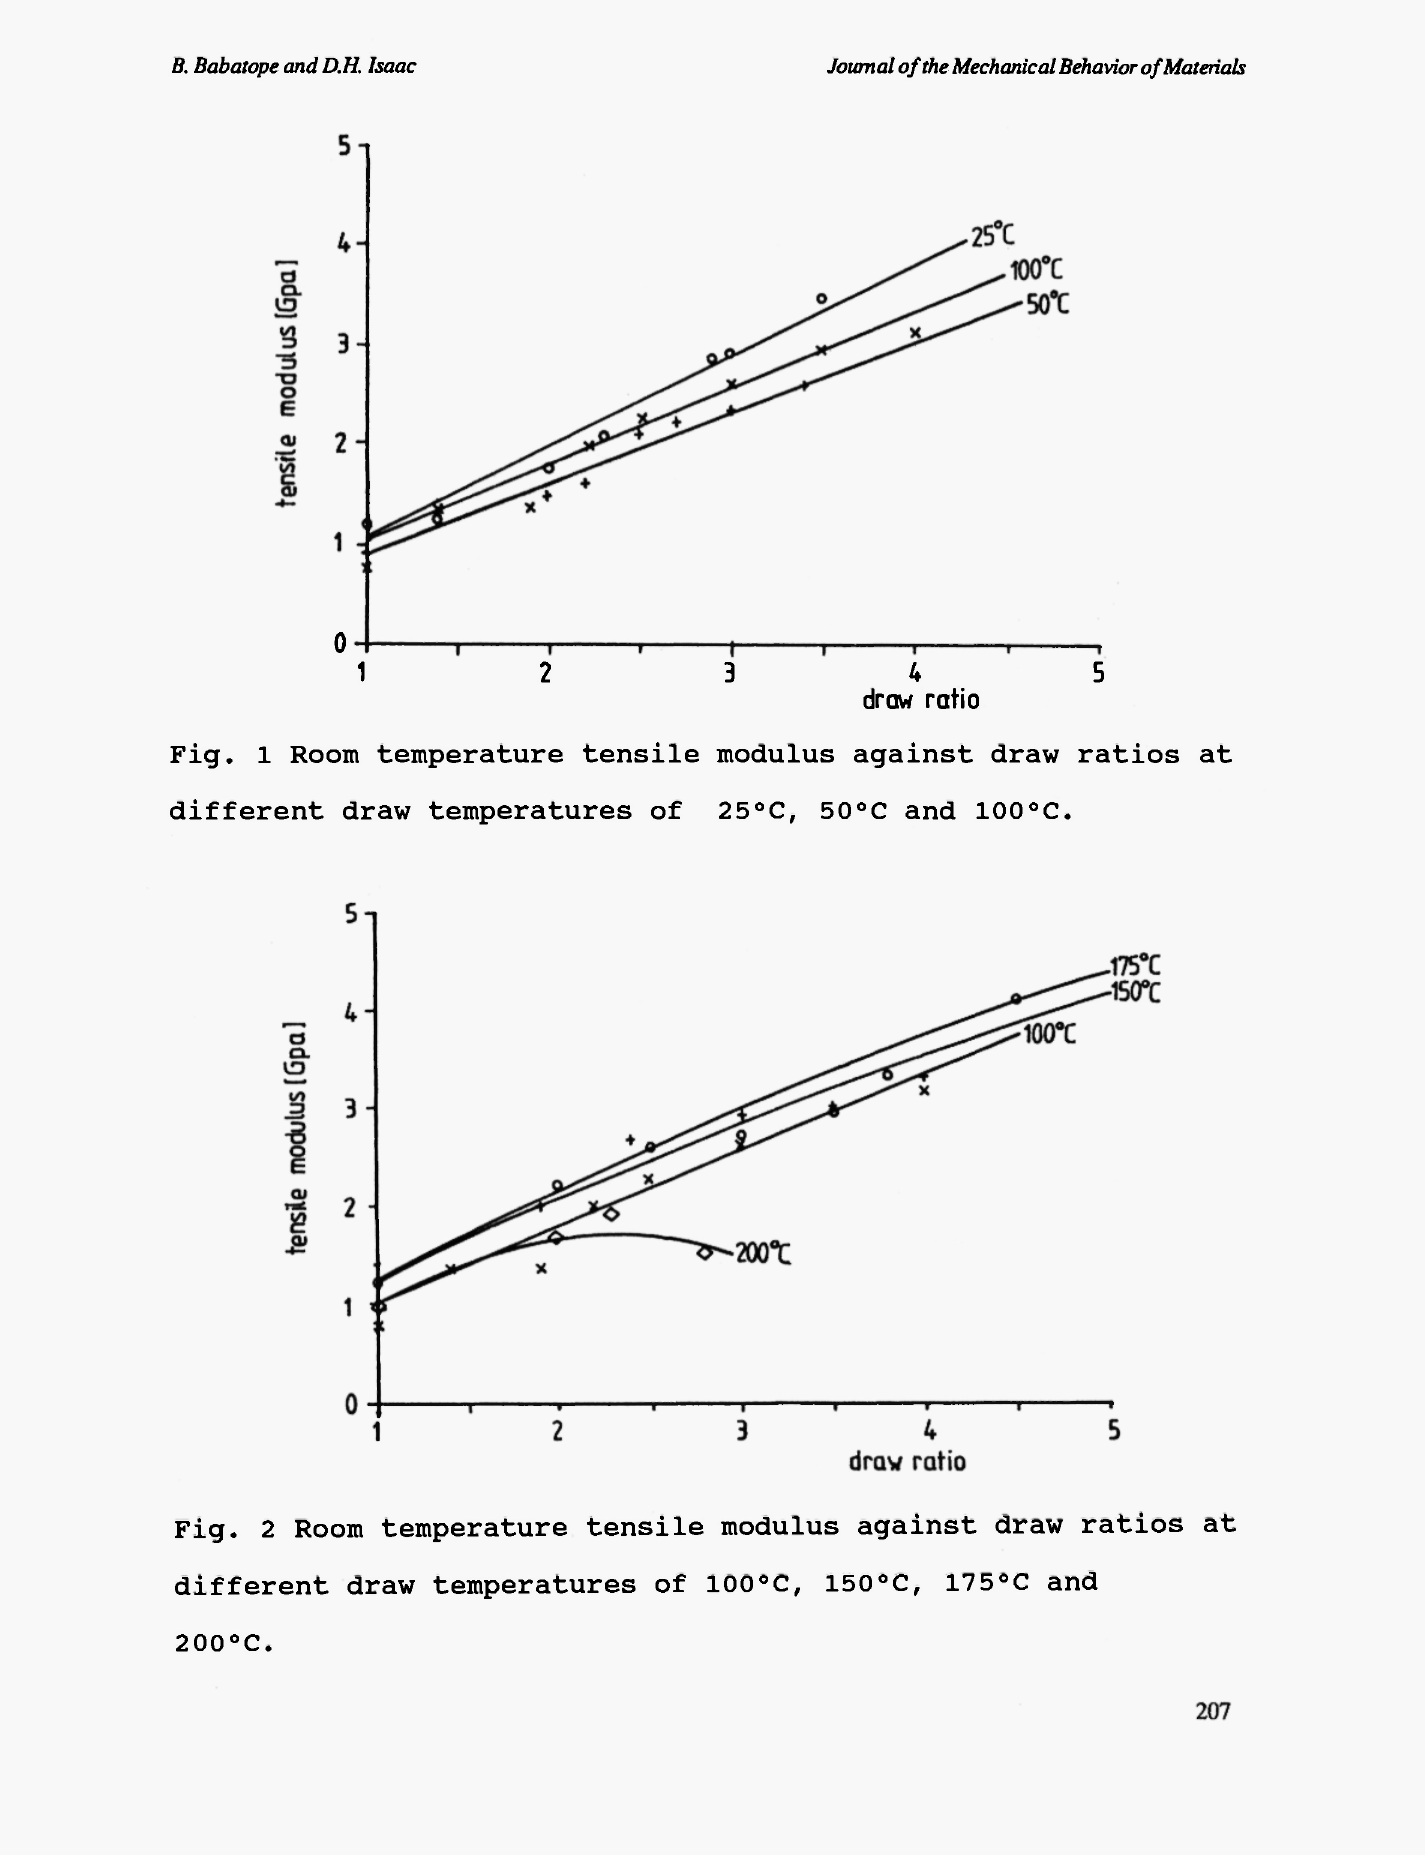
Fig. 1 Room temperature tensile modulus against draw ratios at different draw temperatures of 25°C, 50°C and 100°C.